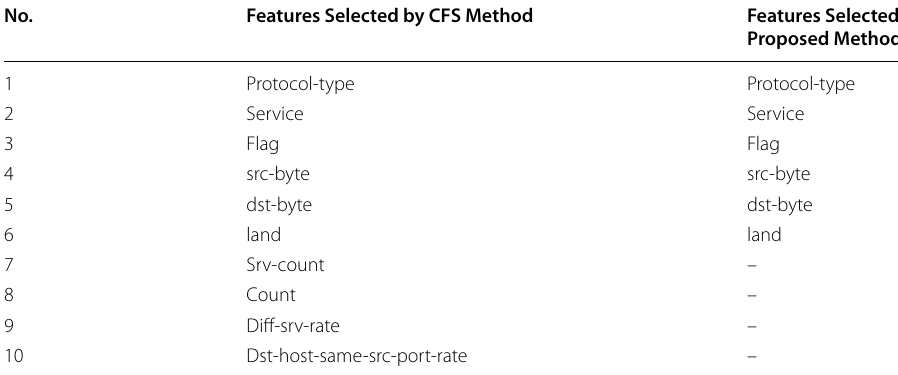
Table 24 Selected features by CFS method and proposed method on P-dataset